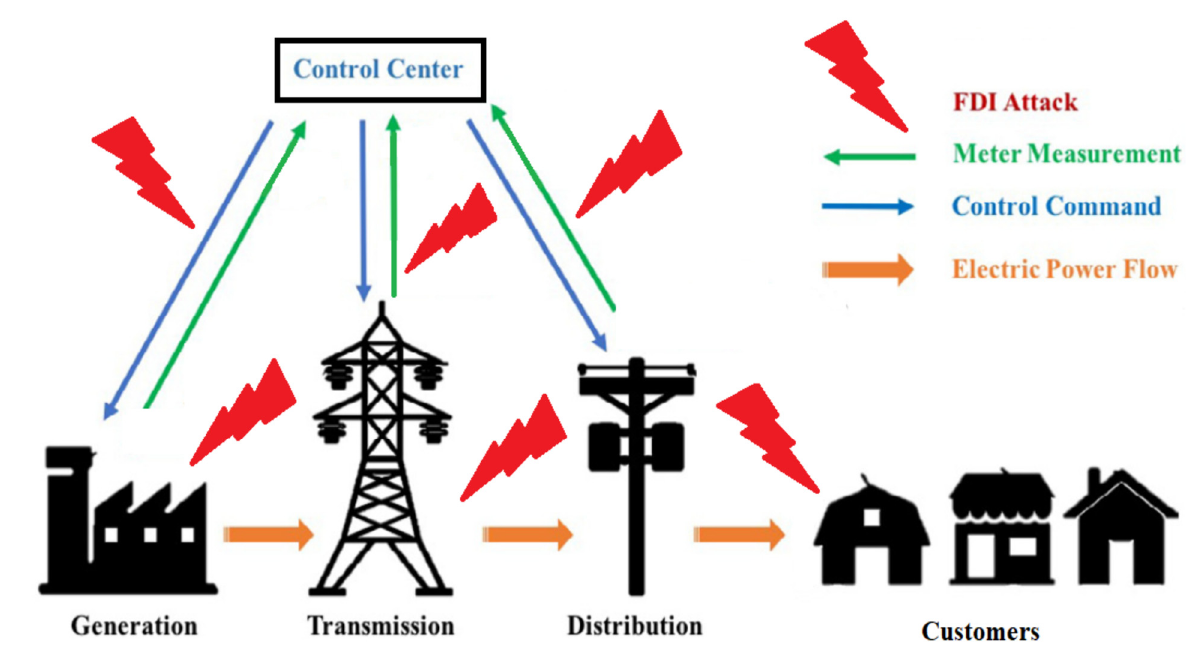
Figure 8. FDIA Scenarios in SG.